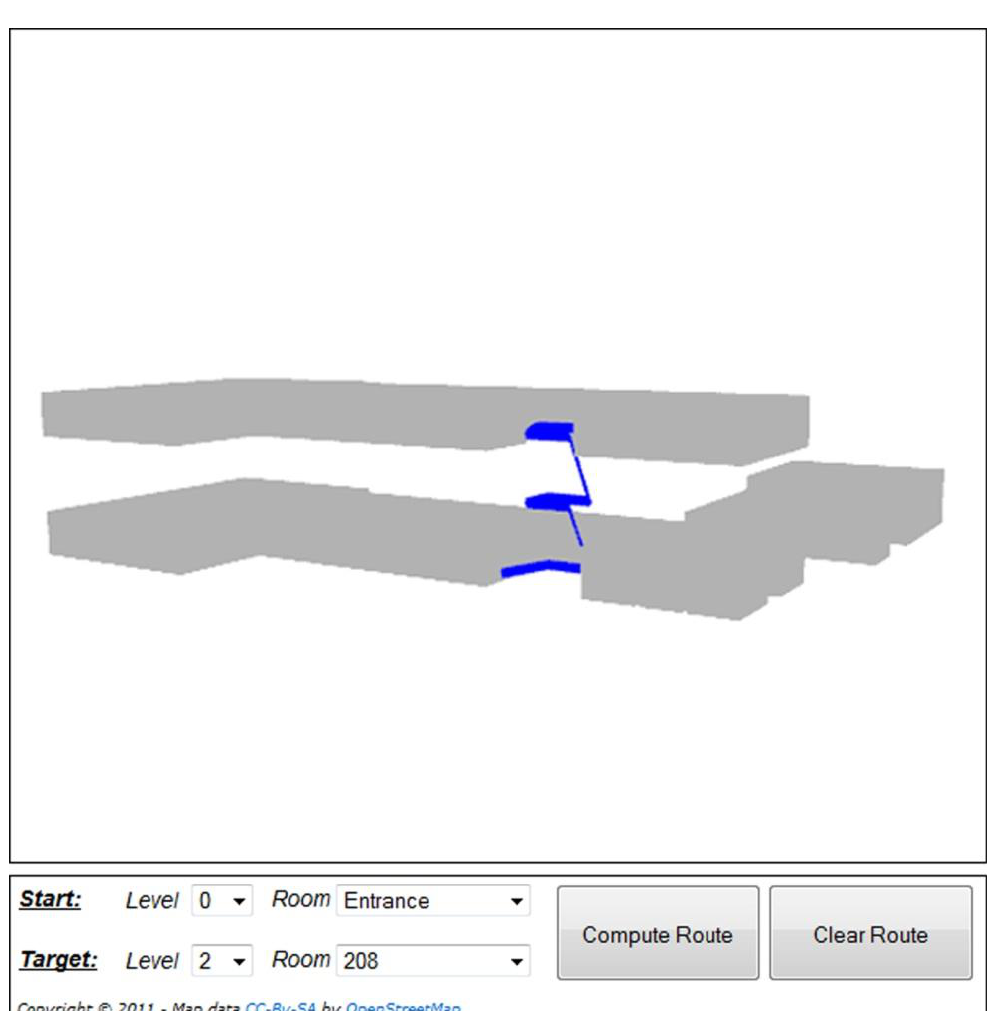
Figure 7. 3D visualization for a computed route between user-defined start and target inside the